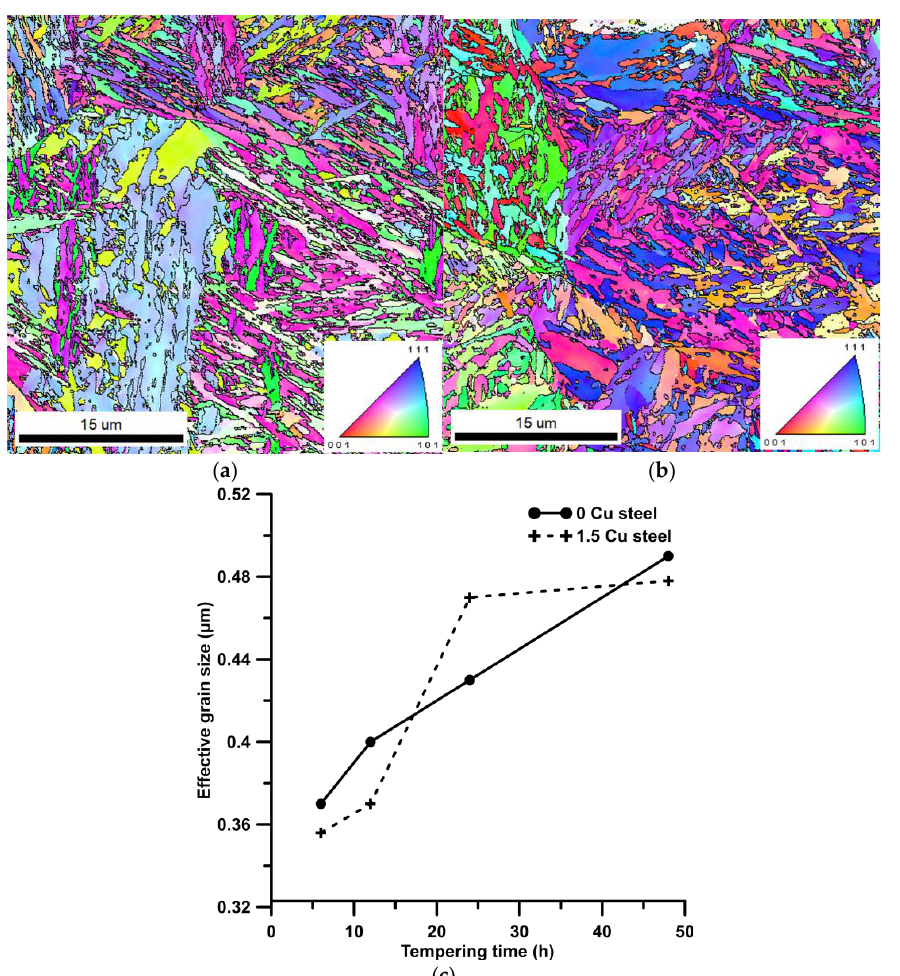
Figure 8. Grain orientation IPF EBSD maps of 0 Cu ( a ) and 1.5 Cu ( b ) steel tempered at 500 °C for 24 h. Black lines show high-angle grain boundaries with misorientation above 15°. Evolution of grain size during tempering ( c ).